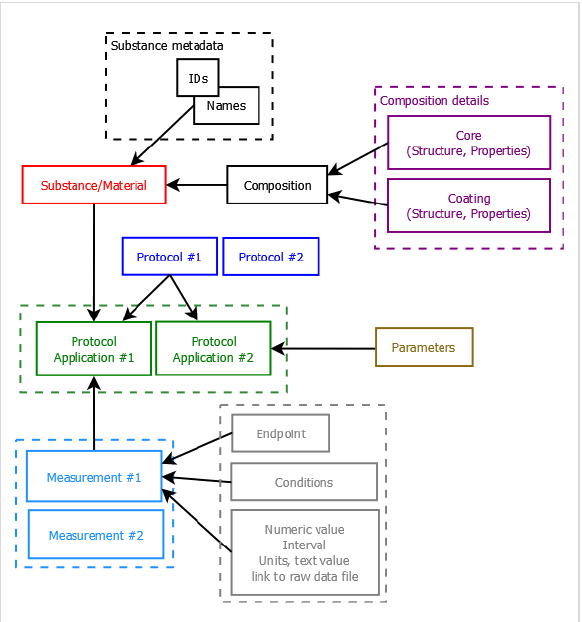
Figure 7: Outline of the data model: Substances are characterised by their “composition” and are identified by their names and IDs. The event of applying a test protocol to a substance/material is described by a “protocol application” entity. Each protocol application consists of a set of “measurements” for a defined “endpoint” under given “condi- tion”. The measurement result can be a numeric value with or without uncertainty specified, an interval, a string value, or a link to a raw data file (e.g., a microscopy image).